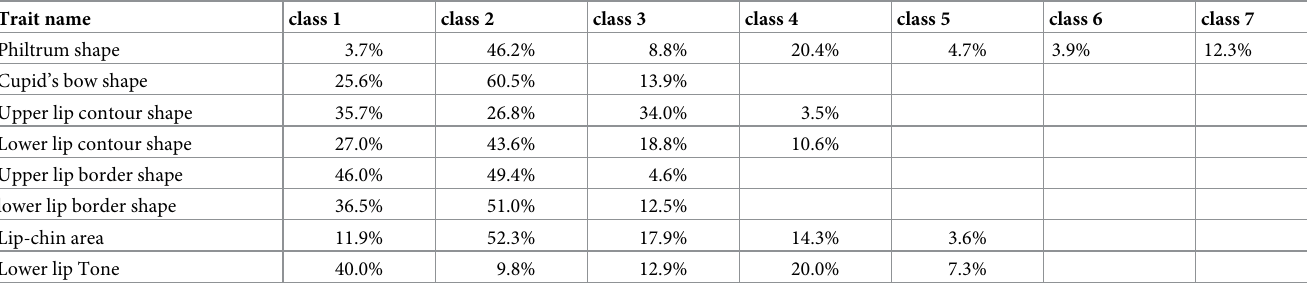
Table 8. Prevalence of lip traits in ALSPAC dataset(%).